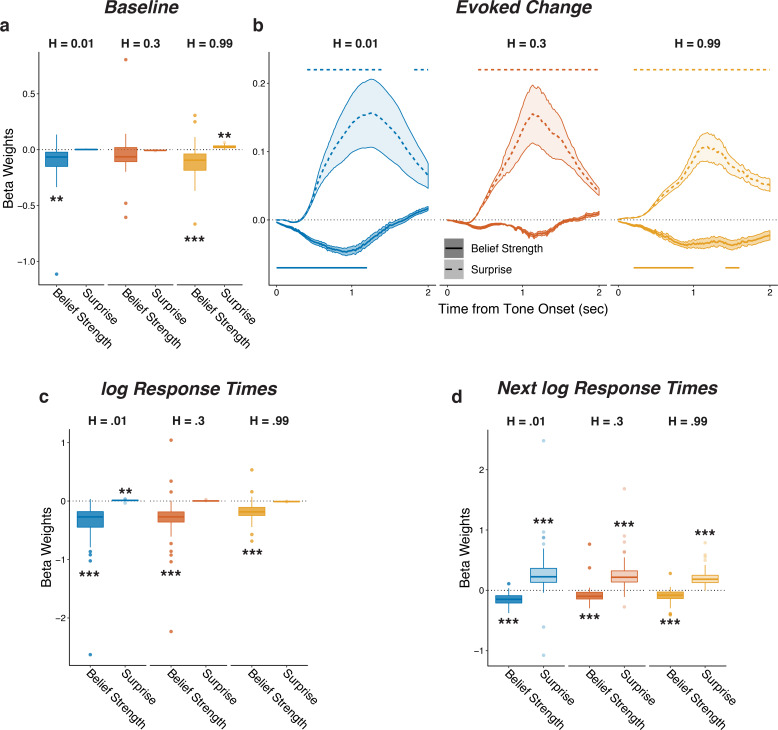
Pupil size encoded belief strength and surprise.Each panel shows two-tailed linear mixed-effects beta weights estimating the influence of subject absolute belief strength and surprise on: (a) baseline pupil diameter, after accounting for the evoked pupil change from the previous trial; (b) evoked change in pupil diameter, after accounting for baseline pupil on the current trial along with the baseline pupil and the evoked pupil from the previous trial; (c) log RT (i.e., the time taken to make a prediction before hearing the tone); and (d) log RT on the next trial. Note that surprise depended on the current belief strength that was present before tone onset, which likely explains the small modulations by surprise in the high-hazard baseline pupil and low-hazard prediction RT. In a, c, and d, boxplots show median, IQR, IQR x 1.5, and outliers; **: p<0.01, ***: p<0.001. In b, lines and shading correspond to mean ± SEM across subjects, and straight lines above (for positive betas) and below (for negative betas) beta values indicate significant timepoints (FWE corrected p<0.05).